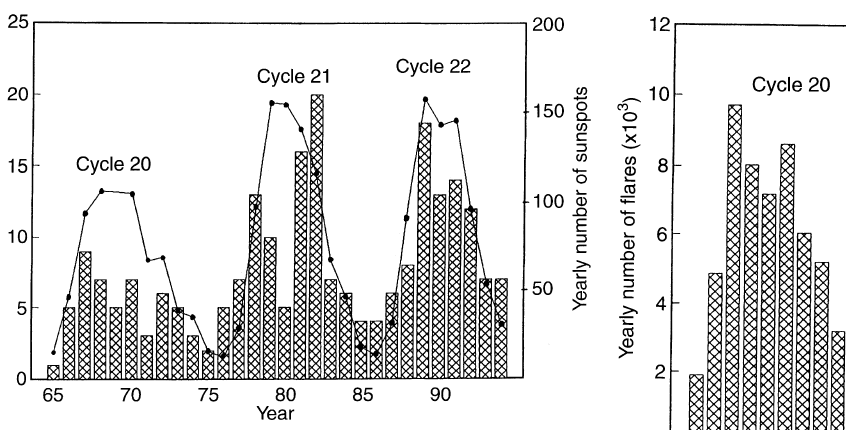
Fig. 1. Annual number of IGSs ( bars ) from 1965 to 1994, corre- sponding to solar cycles 20, 21 and 22. Yearly sunspot numbers are also shown as dots . Both sets of data were obtained from Solar Geophysical Data